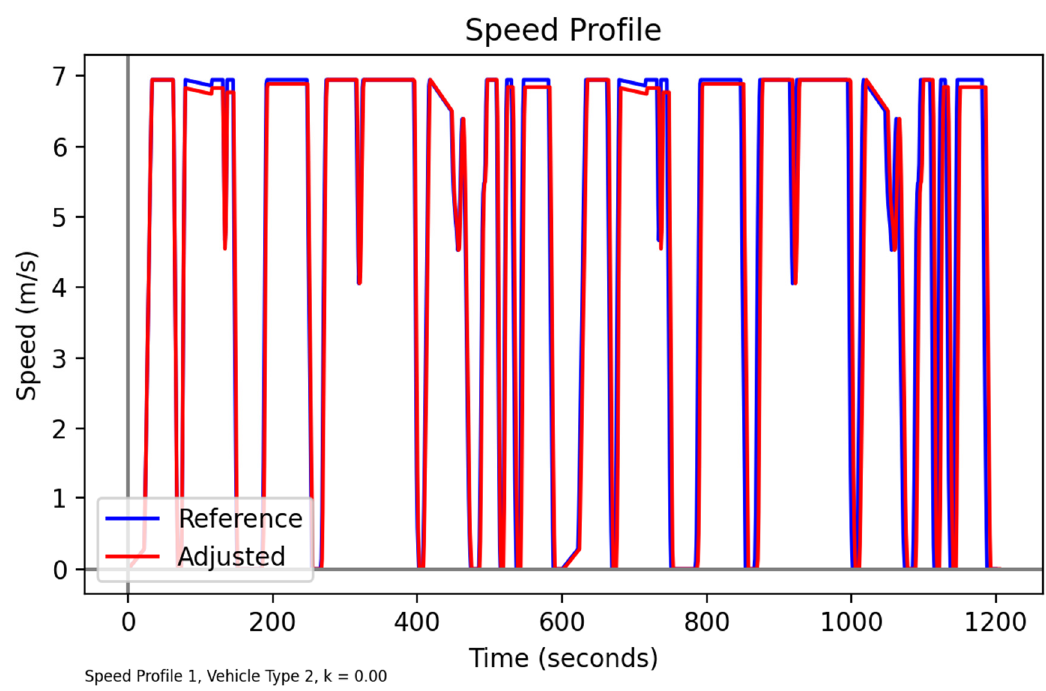
Figure 5. Adjusted speed profile for electric quadricycle in comparison with reference cycle (WMTC Reference Cycle 1, Vehicle Type 2, Flat terrain assumed in adjustment).